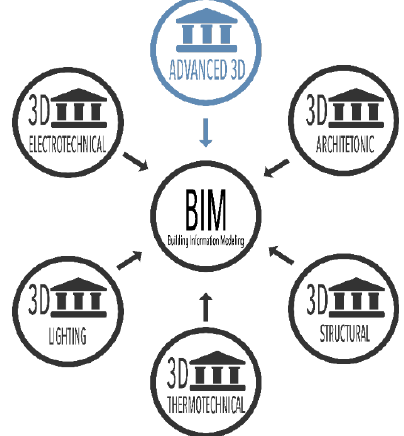
Figure 16. Advanced 3D as part of BIM data